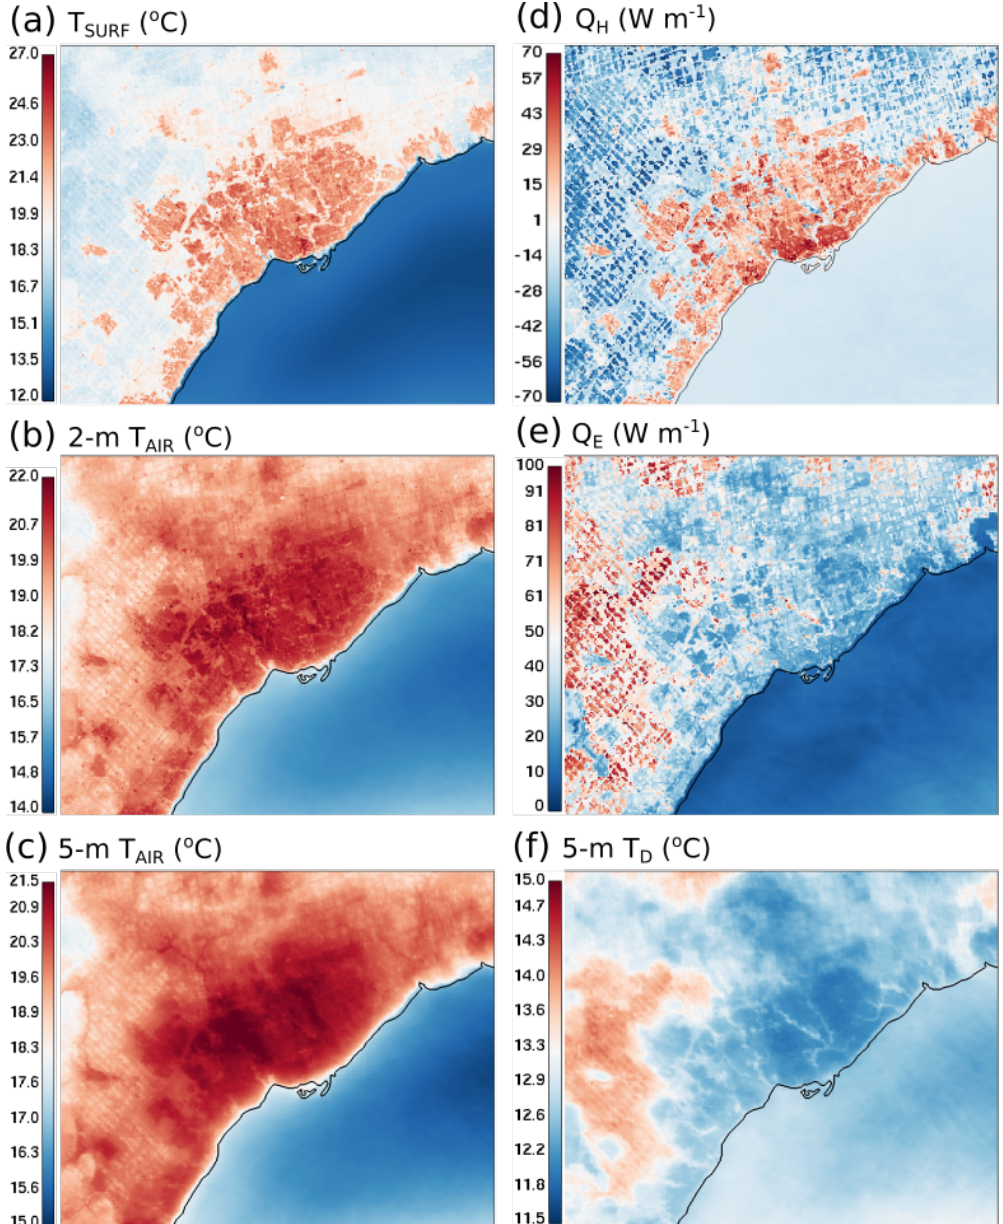
Figure 7. TOR-GEM250 maps at 2000 EDT averaged for the period 13-May–31-Aug. 2015 (detail over the GTA region) for skin surface temperature (°C) ( a ), Air temperature (°C) at ( b ) 1.5 m, and ( c ) 5 m, above ground level, sensible ( d , e ) latent heat fluxes (W m − 1 ), Dew point Temperature at 5 m above canopy level (°C) ( f ). The shoreline is drawn with a black